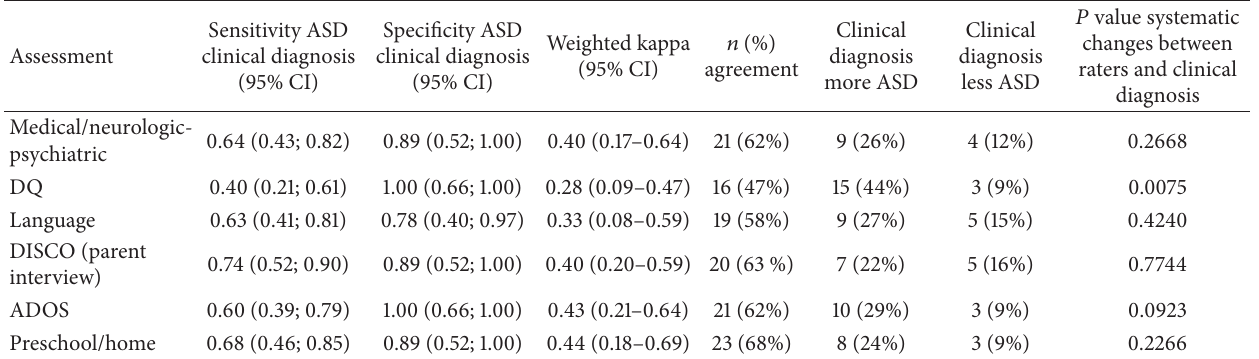
Table 1: Sensitivity, specificity, and agreement of measurements between assessments and clinical diagnosis (all subjects).